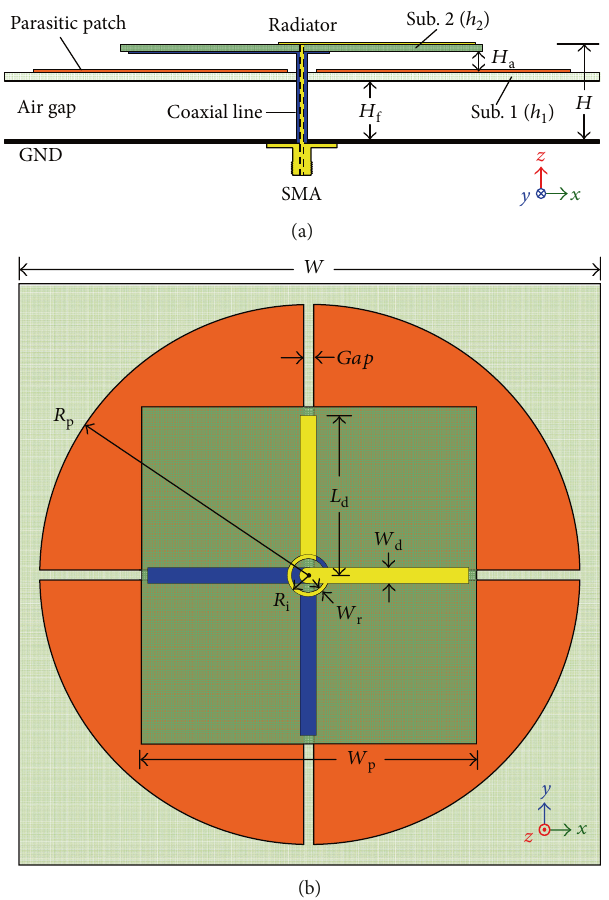
| values of the single-dipole antenna loaded with parasitic patches for di ff erent spacings 11 ). a